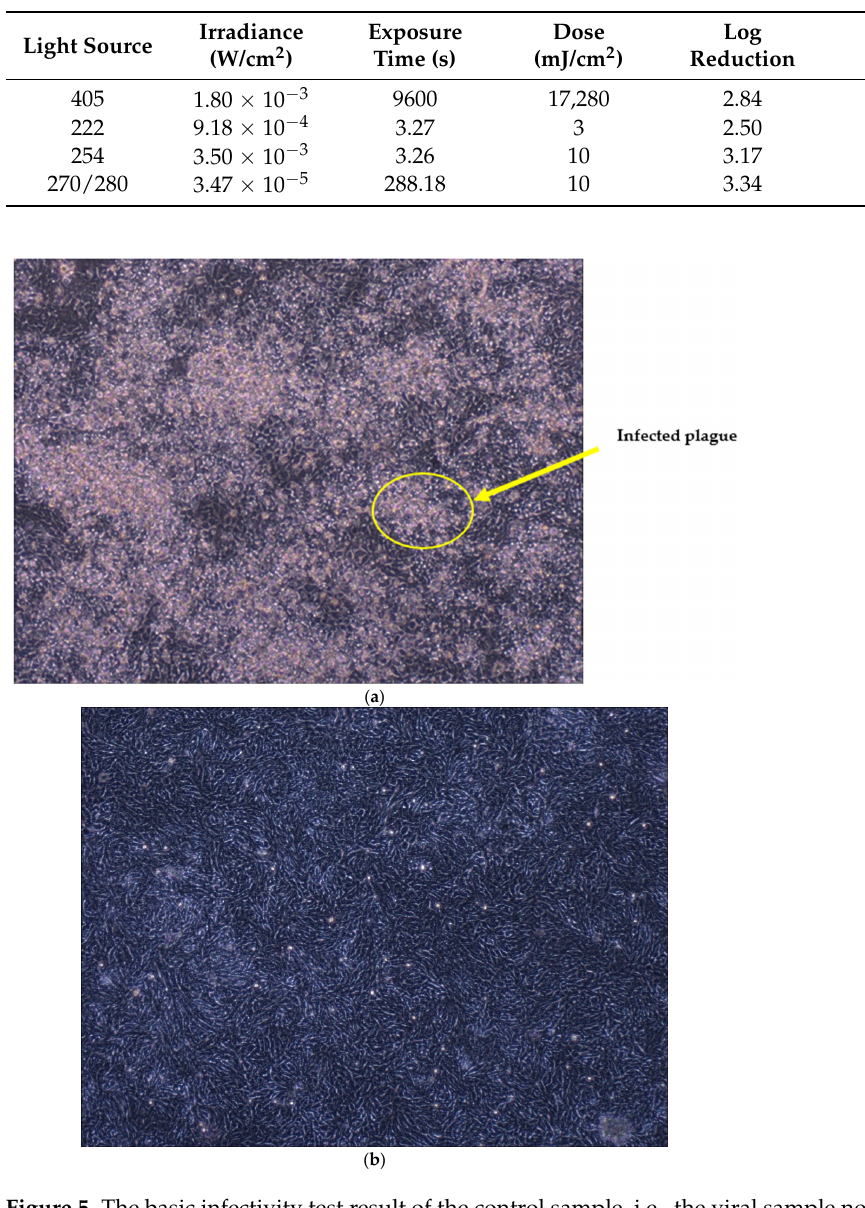
Table 1. Showing the TCID50 results for the exposed virus sample, applied dose, and exposure time for different UVC radiation and blue light.